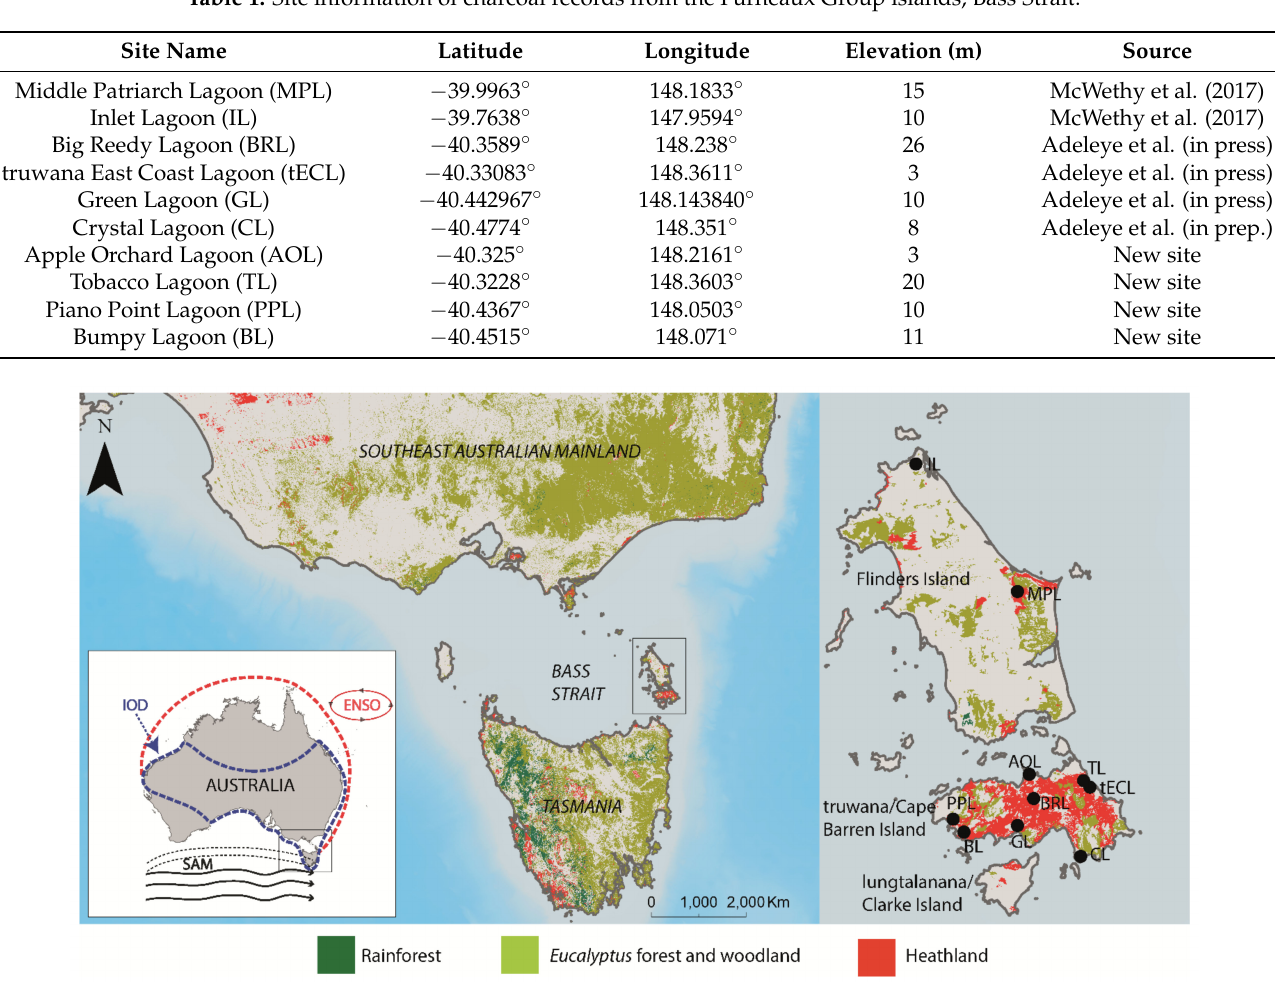
Figure 1. Major climatic modes influencing southeast Australia. A positive Indian Ocean Dipole phase (IOD) generally drives less rainfall, higher temperatures and extreme fire weather in parts of Australia (blue-broken lines) in winter and spring, while